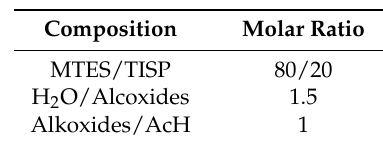
Table 2. Composition of the 80MTES/20TISP sol.